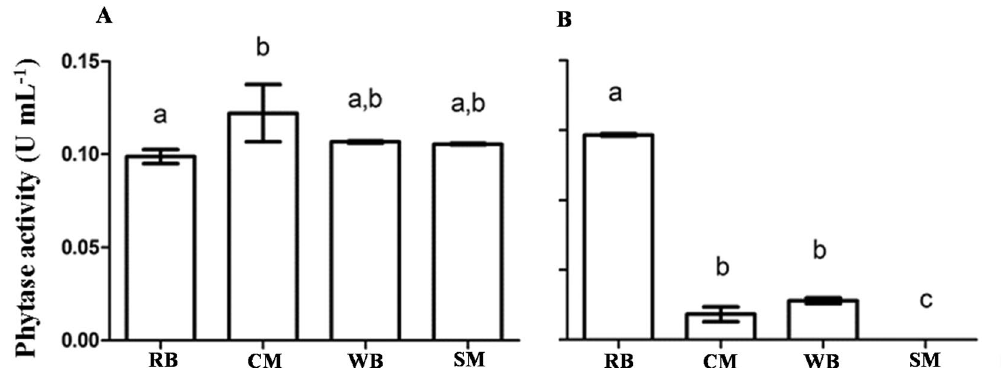
Figure 2. Phytase production by Acremonium zeae B ( A ) and Kluyveromyces marxianus ( B ) in media containing rice bran (RB), corn meal (CM), wheat bran (WB) or soybean meal (SM). A. zeae was grown in semi-solid medium containing 20% (m/v) of the substrate for 120 h and K. marxianus in liquid medium containing 1.0% (w/v) of each substrate for 48 h. The bars correspond to the standard deviations of the means (n = 3). Equal letters do not differ at 95% confidence by the Tukey